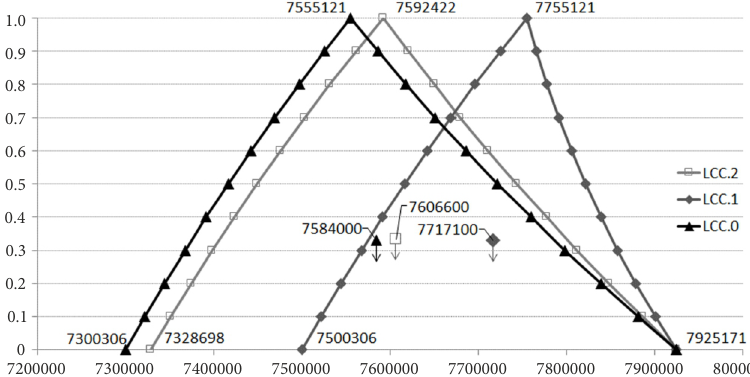
Figure 4. Output membership functions for the criterion